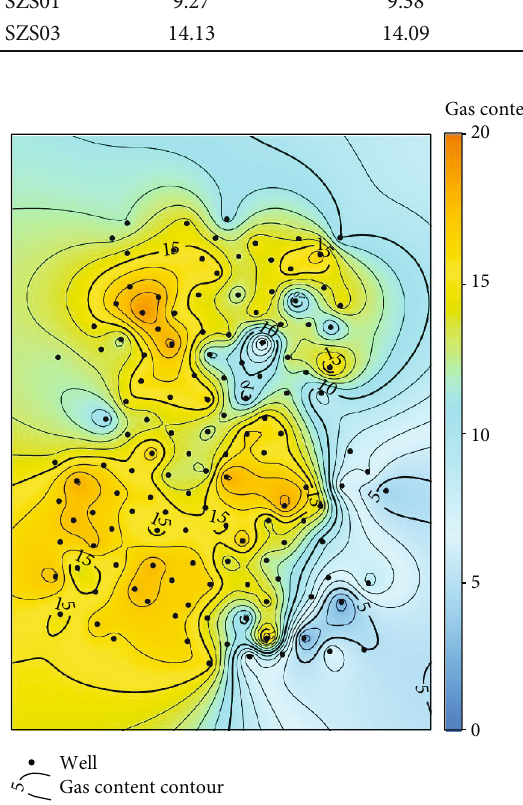
Figure 8: Gas content contour of W block for 3# coal seam of SZ block.